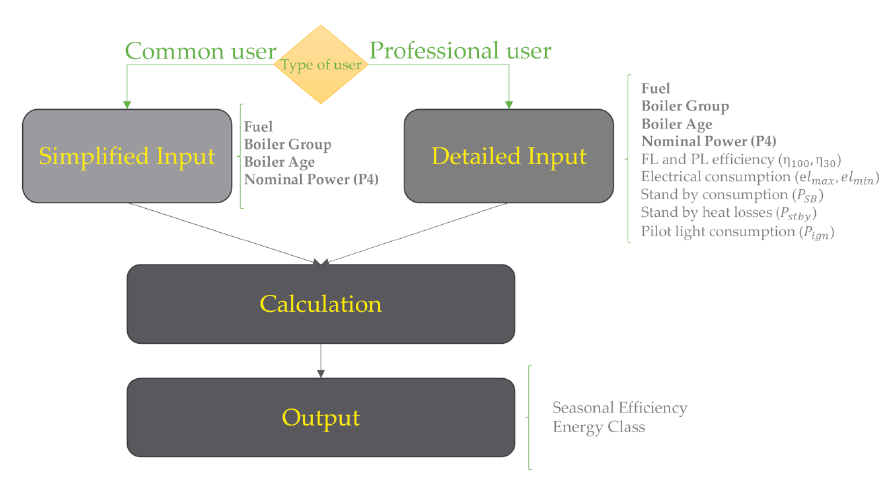
Figure 2. Schematic diagram for the energy labeling of space heating